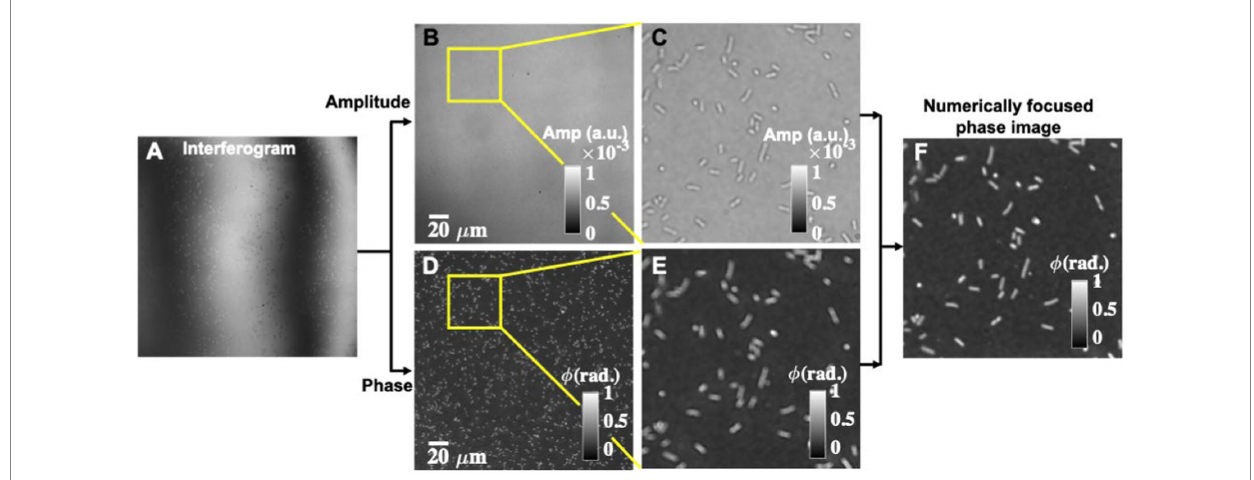
FIGURE 2 Reconstruction of numerically focused phase images using interferometric measurements from the QPM microscope. (A) One of the phase-shifted interferograms. (B,D) Corresponding amplitude and phase map of the bacteria sample. (C,E) Zoomed views of the amplitude and the phase images of the regions marked with yellow color boxes. (F) Numerically focused phase map.